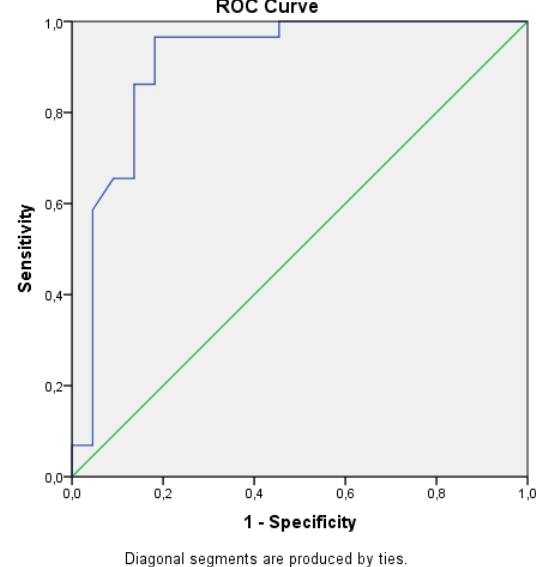
Fig. 3. ROC analysis of the pNfL of patients with and without WB atrophy. The sensitivity and specificity of the predictive model were 93.5% and 75%, respectively, with a cut-off level of 8.5 pg/mL for NfL, and an area under curve (AUC) of 0.905 (95% CI: 0.803–1.0; P <0.001). Higher pNfL values indicate stronger evidence for the presence of WB atrophy. AUC, Area under the curve; NEDA, No evident disease activity; pNfL, plasma neurofilament light chain; ROC, Receiver operat- ing characteristics; WB, Whole brain.